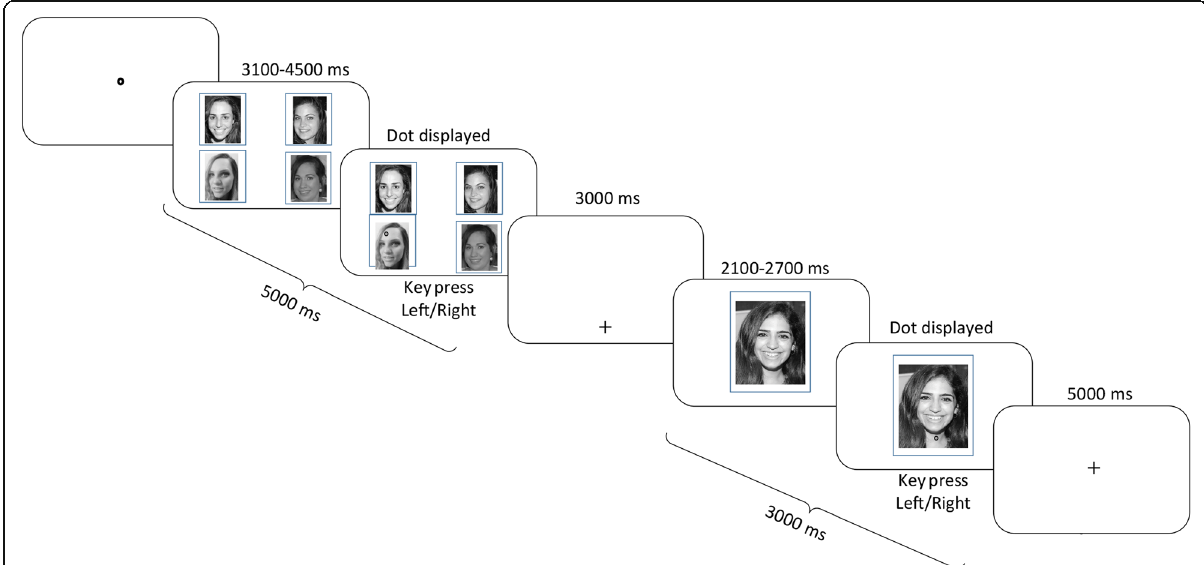
Fig. 1 Illustration of the experimental procedure. A trial begins with a parallel display of four faces. A gray dot appears on one of the faces, between 3100 and 4500ms after the parallel display onset, and participants are asked to report whether it appeared on the right or left side of the screen. Afterwards, a blank screen is presented followed by a single face. Between 2100 and 2700ms after the single display onset, a gray dot appears on the face and participants are required to report again on which side of the screen the dot apeared. A personally familiar face could be presented in the parallel display, in the single display, in both displays or in none of